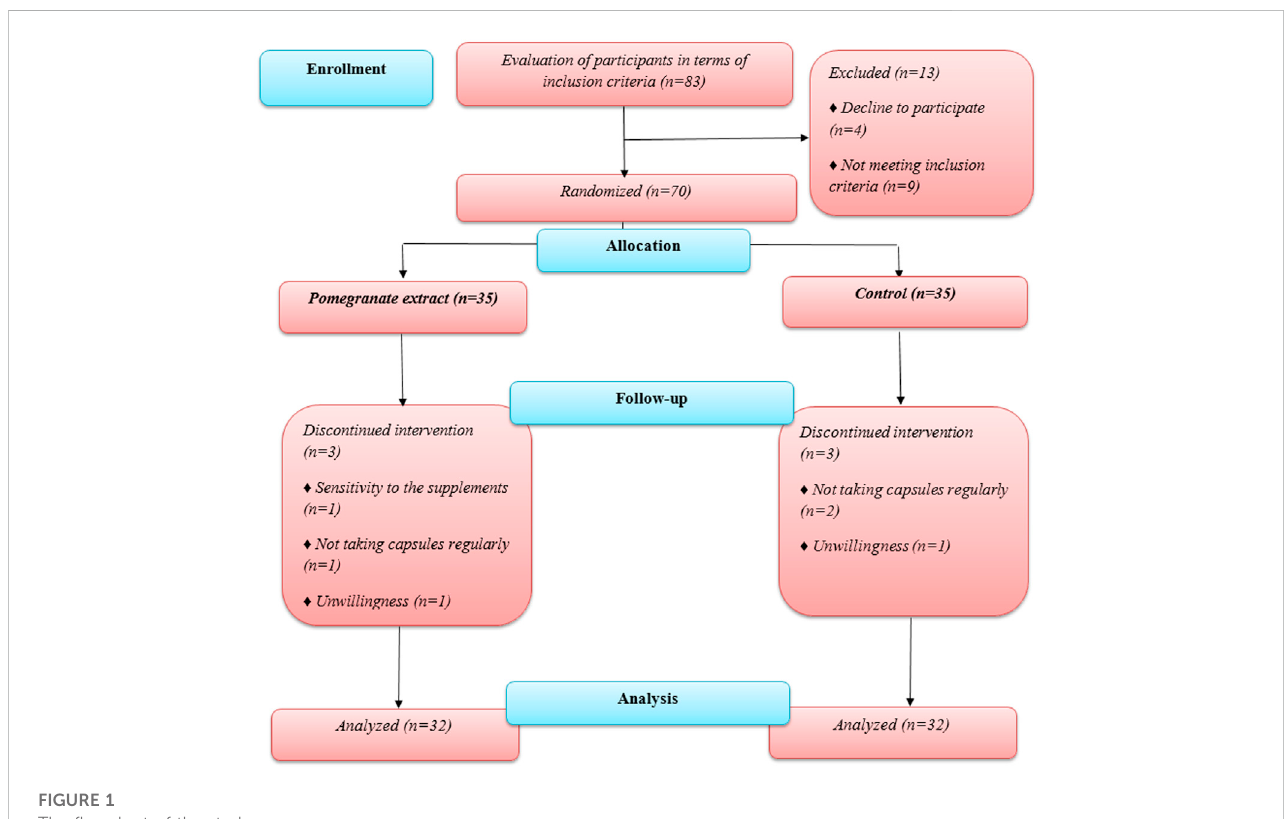
FIGURE 1 The fl owchart of the study.